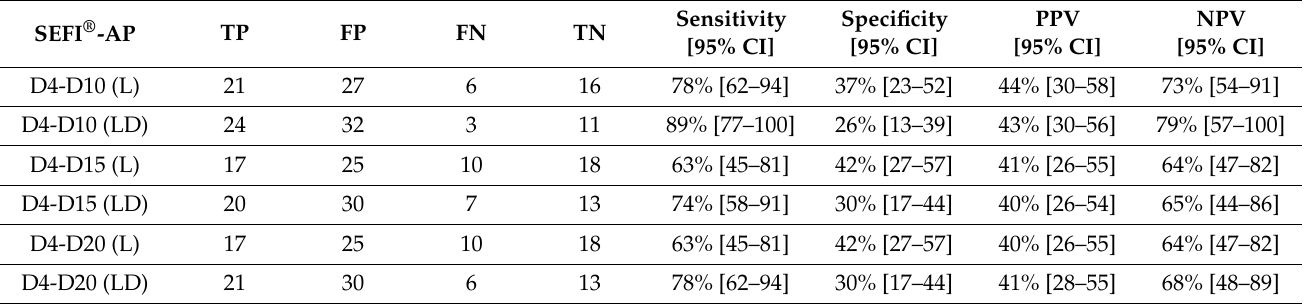
Table 4. Sensitivity, specificity, positive and negative predictive values of the Simple Evaluation of Food Intake ® assisted by photography (SEFI ® -AP) at day 3 to anticipate food intake during the following 5, 10, 15 or 20 days (n =